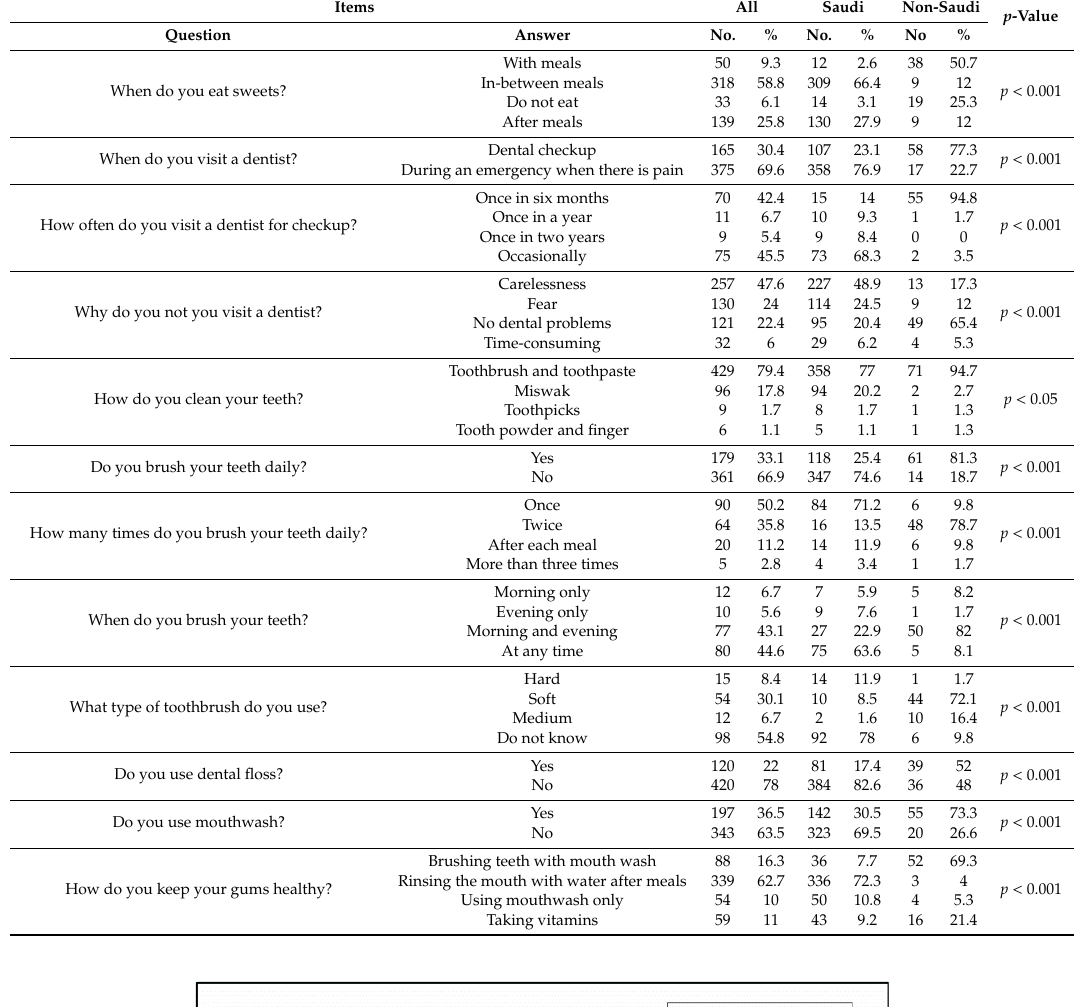
Table 3. Practice of preventive measures.